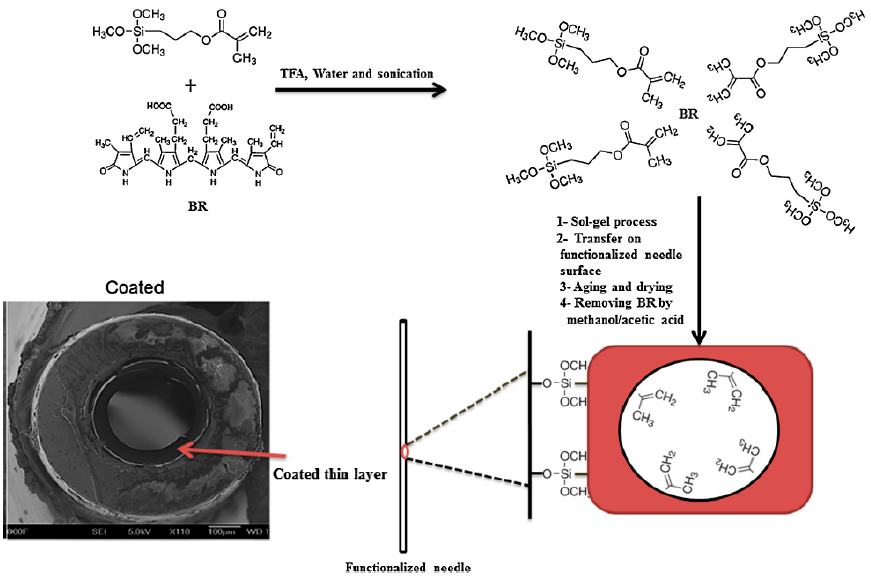
Figure 3. MIP xerogel in a needle [41].